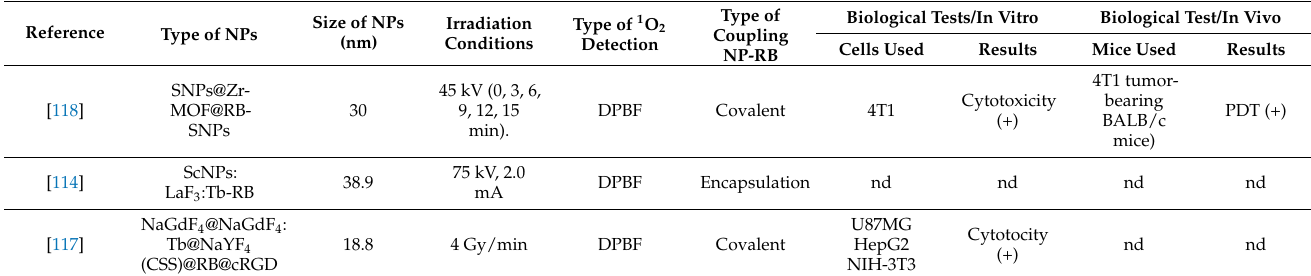
Table 10. References dealing with lanthanide@MOF, nanoprobes@RB, nanophosphors@RB and ScNPs@RB under X-ray, including the type of NPs, along with their size, excitation wavelength, type of detection of 1 O 2 , type of coupling between the NPs and the RB, and the type of biological tests performed.